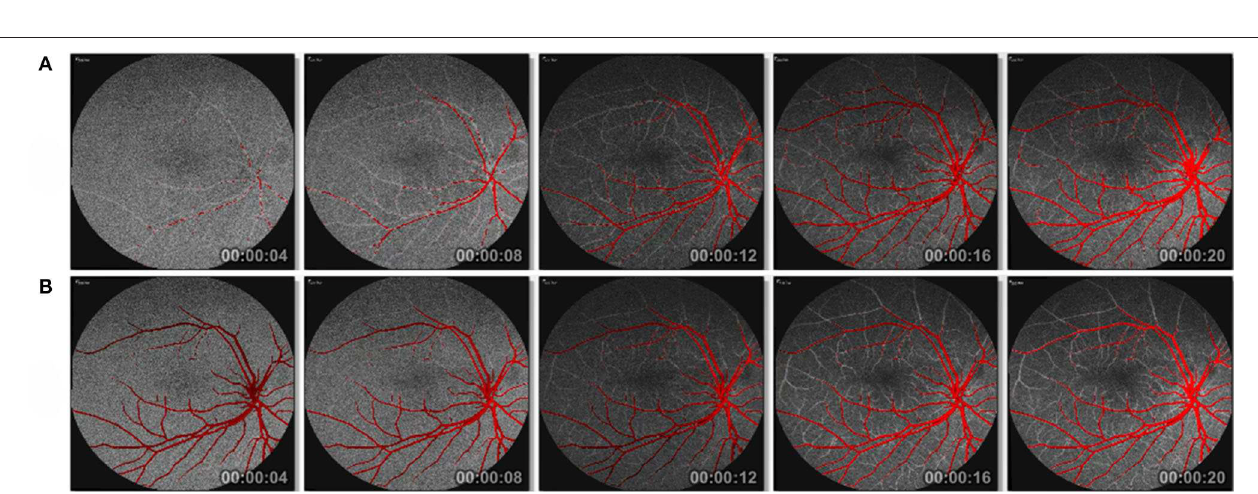
FIGURE 13 | Eulerian video magnification of registered and segmented FA frames (A) without mean intensity projection and (B) with mean intensity projection of masks. See Supplementary Videos for the frames shown here.